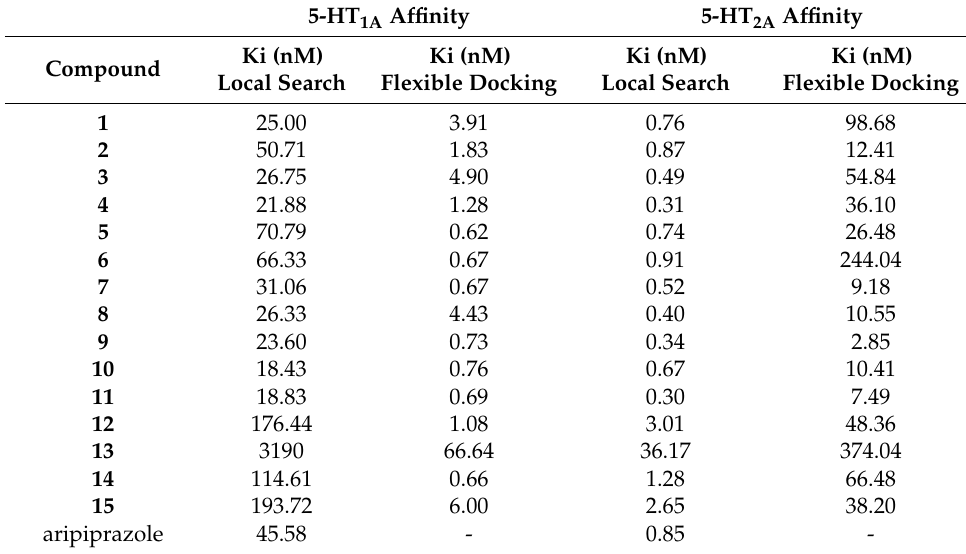
Table 3. Predicted affinities of compounds 1 – 15 to 5-HT